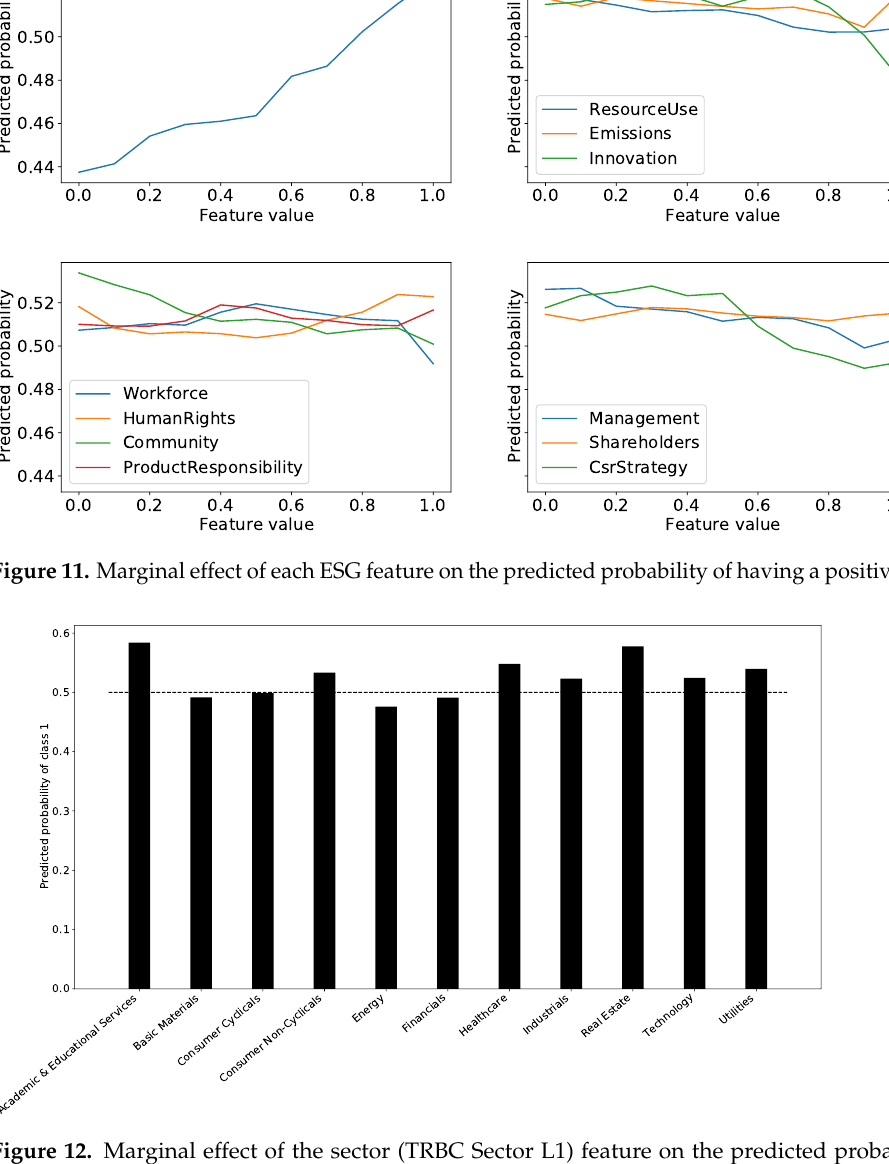
Figure 12. Marginal effect of the sector (TRBC Sector L1) feature on the predicted probability of having a positive